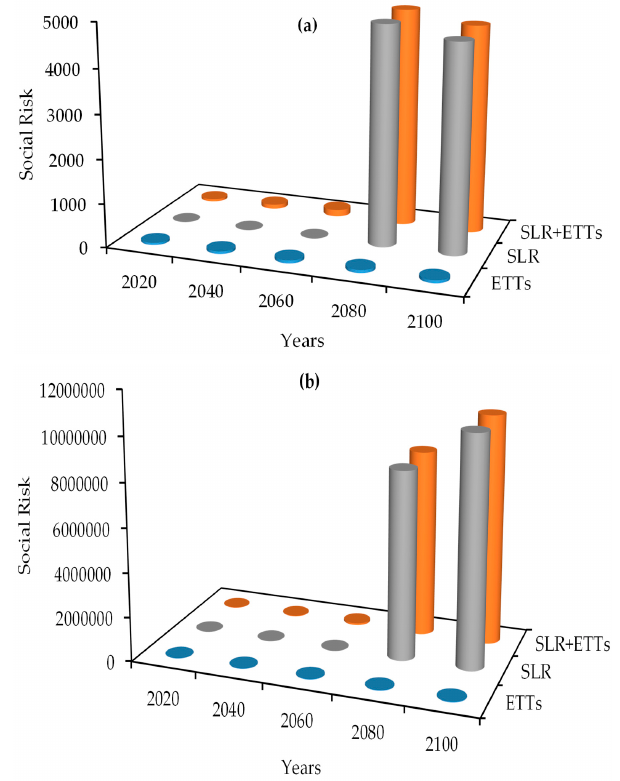
Figure 10. Projected social risk values for ( a ) Fethiye City Center, Turkey and ( b ) the Cairo Agricultural Area, Egypt. A comparison of economic risks at Fethiye due to SLR and ETTs+SLR is given in Tables 3 and 4, respectively. For Fethiye, the social risks due to SLR and ETTs+SLR are given in Tables 5 and 6, respectively. Table 3. Economic Risks (ER) at Fethiye due to Sea Level Rise (SLR).